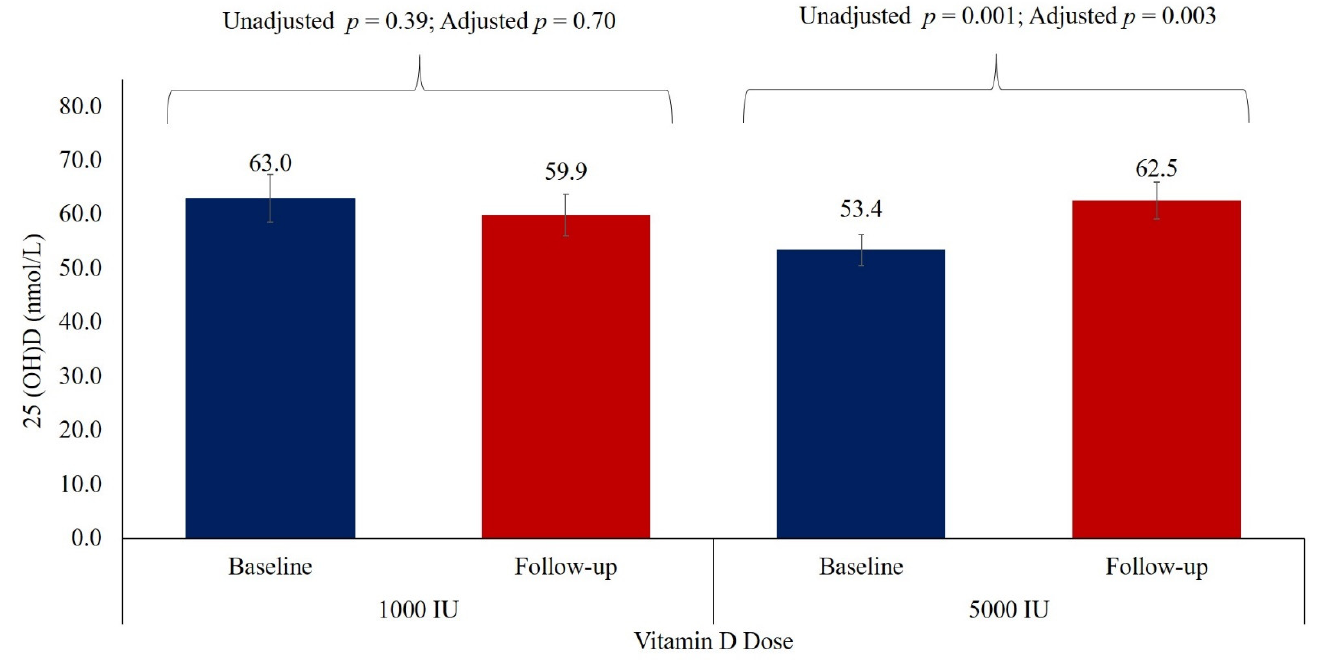
Figure 3. Mean 25(OH) D concentration before and after